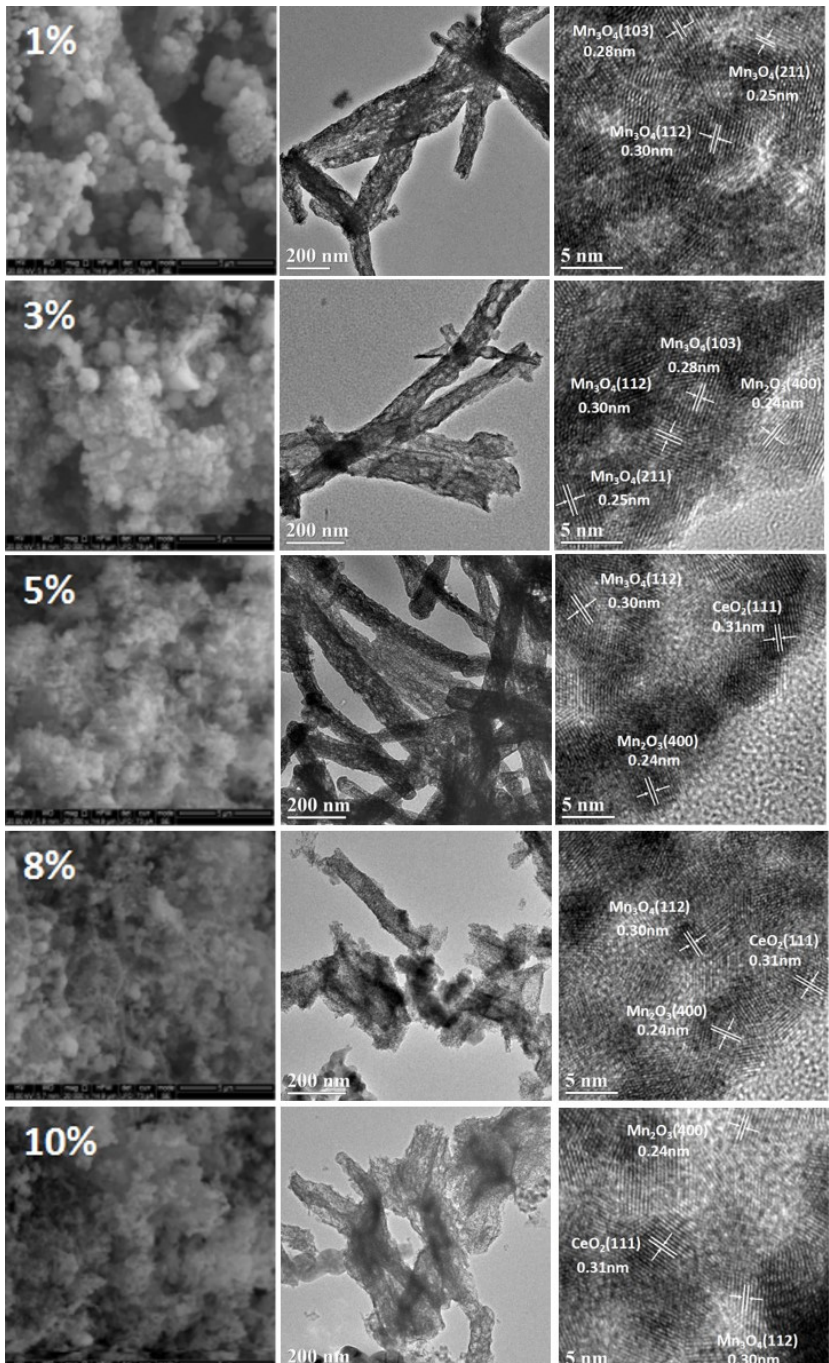
Figure 4. SEM ( left ) and HRTEM ( middle and right ) of w CeO 2 –MnO X (From top to bottom: 1%, 3%, Figure 4. SEM (left) and HRTEM (middle and right) of w CeO 2 –MnO X (From top to bottom: 1%, 3%, 5%, 8% and 5%, 8% and 10%).